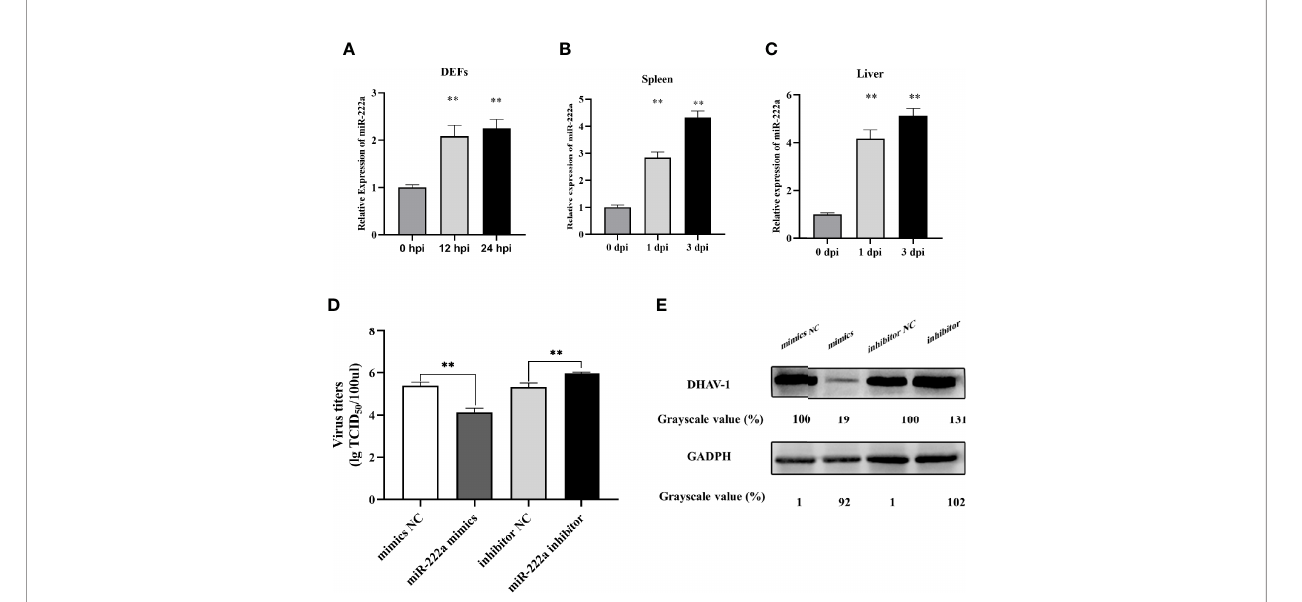
FIGURE 8 | miR-222a expression changes in the DEFs (A) , spleen (B) , and liver (C) after DHAV-1 infection. DEFs were transfected with corresponding miRNA mimics or miRNA inhibitors (100 nM) then were infected with DHAV-1 at an MOI of 3. Twenty-four hours after infection, viral titers were measured by TCID50 (D) and DHAV-1 viral protein expression were detected by western blot (E) . ** indicated P <